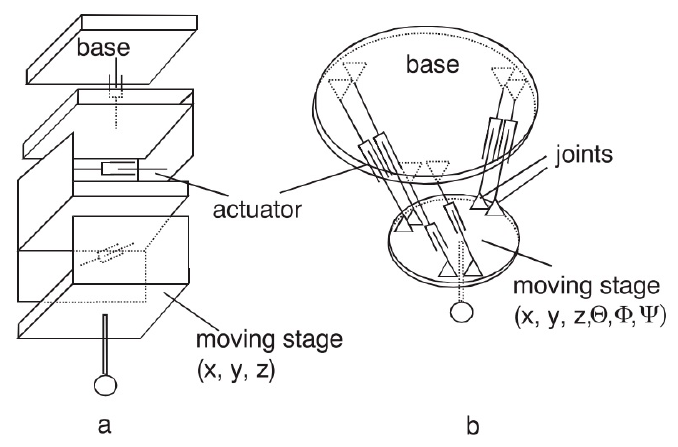
Figure 16. ( a ) serial and ( b ) parallel kinematics probes [119].